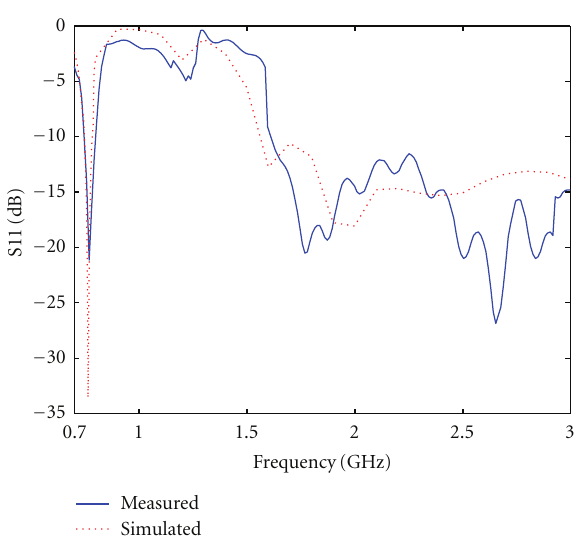
Figure 6: Simulated and measured S11 of the proposed antenna.